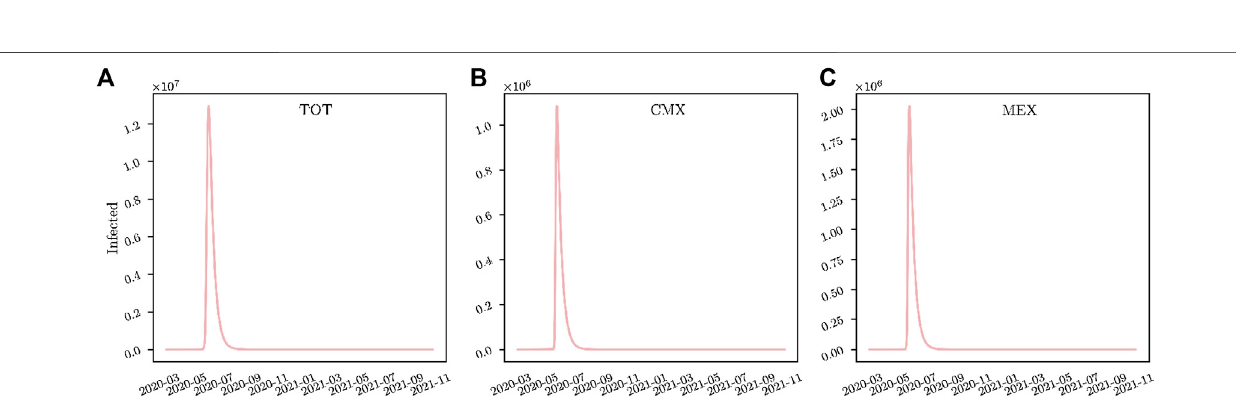
Frontiers in Physics |